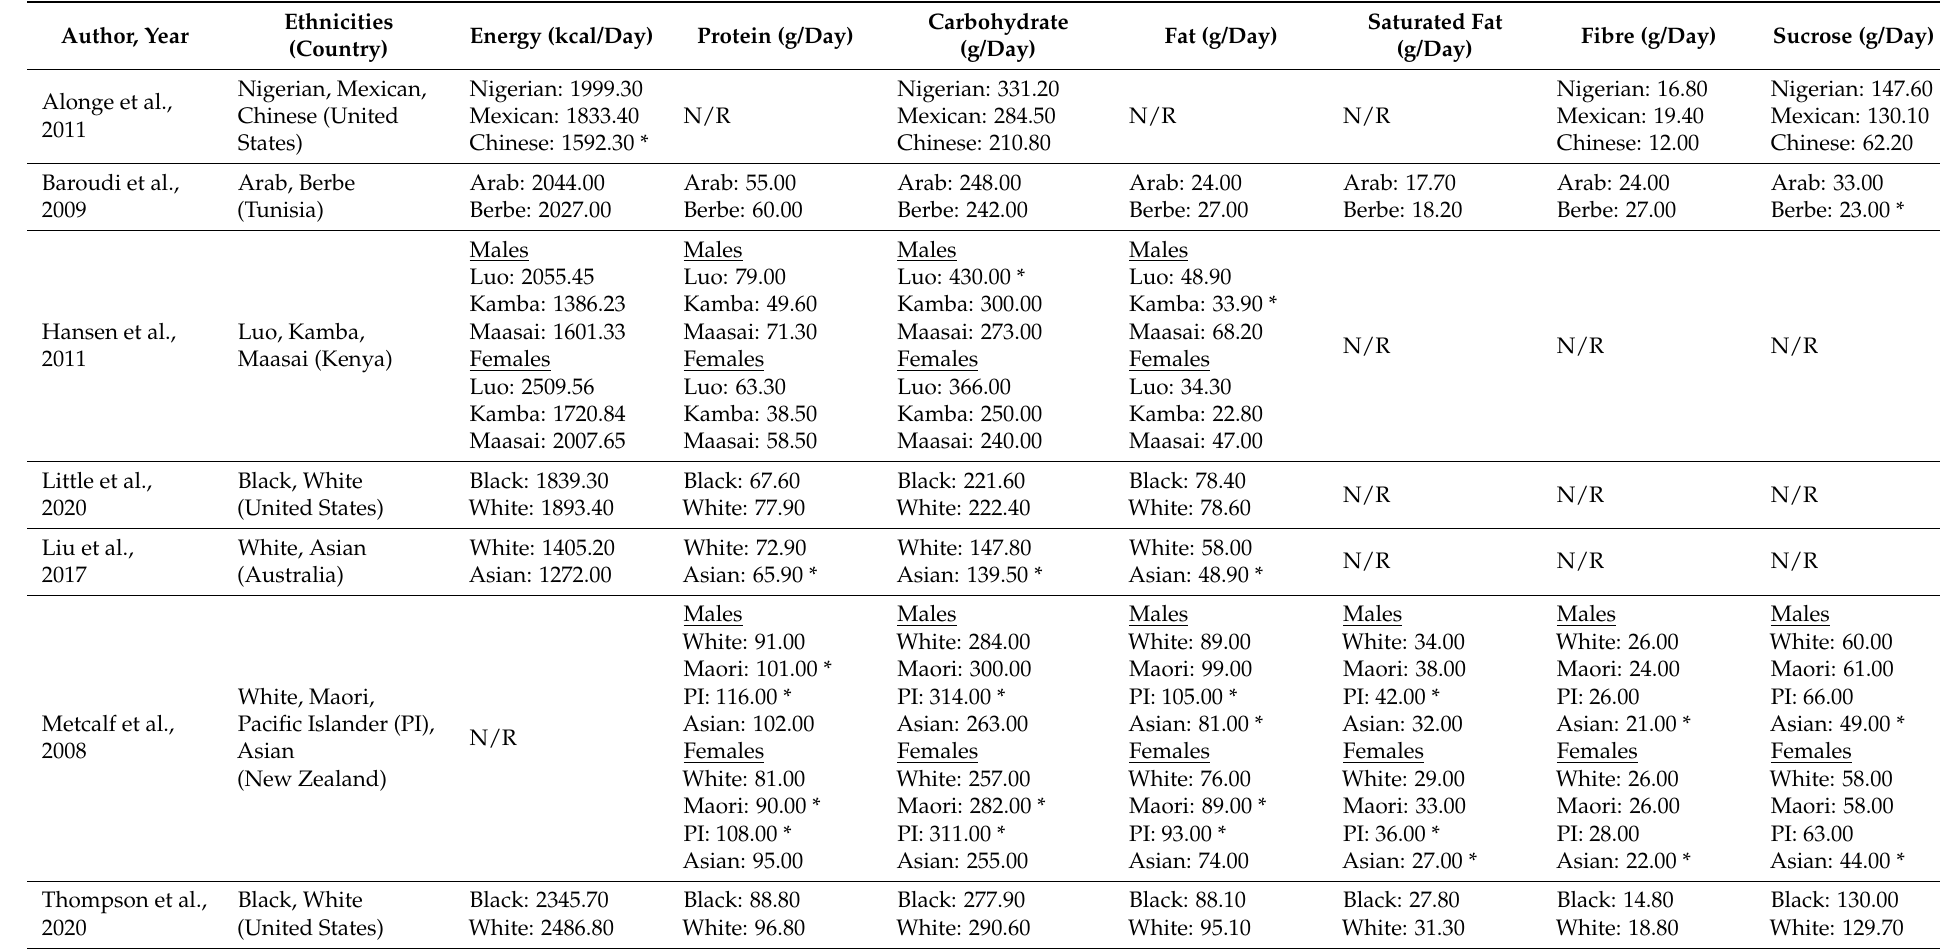
Table 2. Mean daily macronutrient intakes across different ethnic groups.